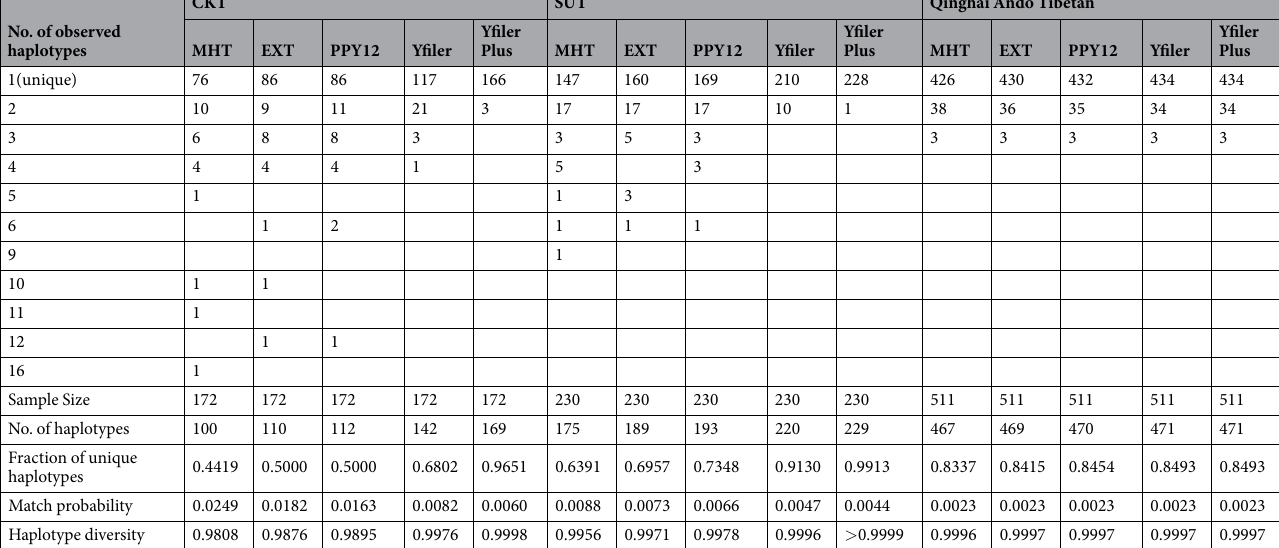
Table 1. The forensic parameters estimated for different combinations of Y-STRs in three different Tibetan populations MHT: minimal haplotype; EHT: the extended haplotype; PPY12: PowerPlex Y haplotype; Yfiler: Yfiler PCR Amplification Kit; Yfiler Plus: Yfiler ® Plus PCR Amplification Kit. SUT: Shigatse Ü-Tsang Tibetans (SUT), CKT: Chamdo Kham